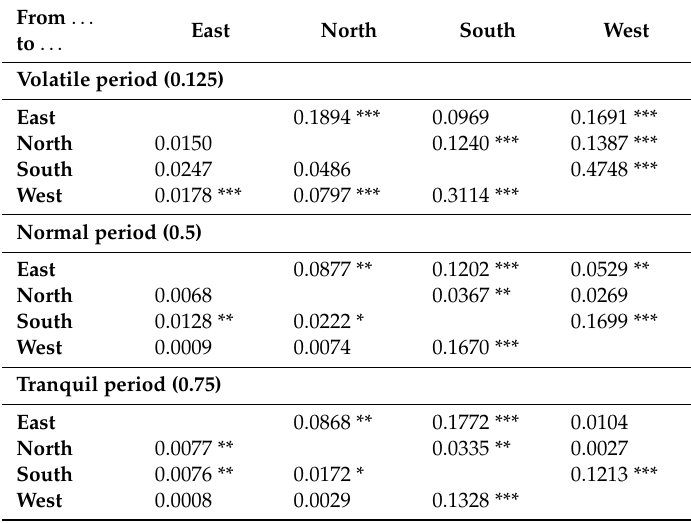
Table 1. Spillover coe ffi cients of the state-dependent sensitivity VaR model (SDSVaR) model, based on geographical position.